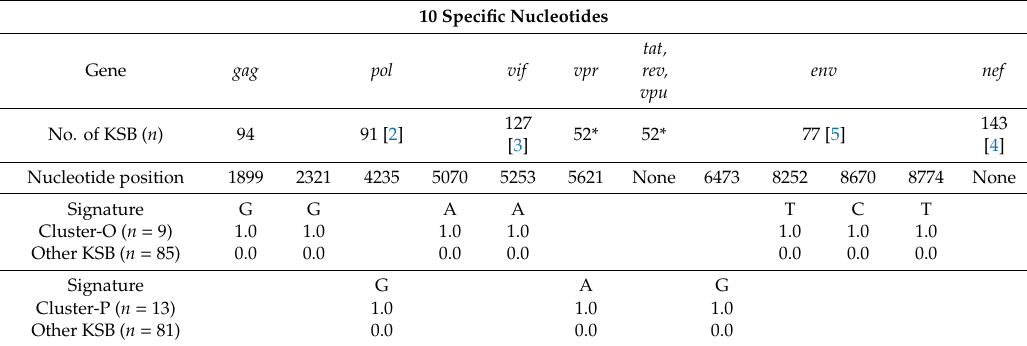
Table 3. Comparison of the frequency of the signature pattern nucleotides among six genes. 10 Specific Nucleotides